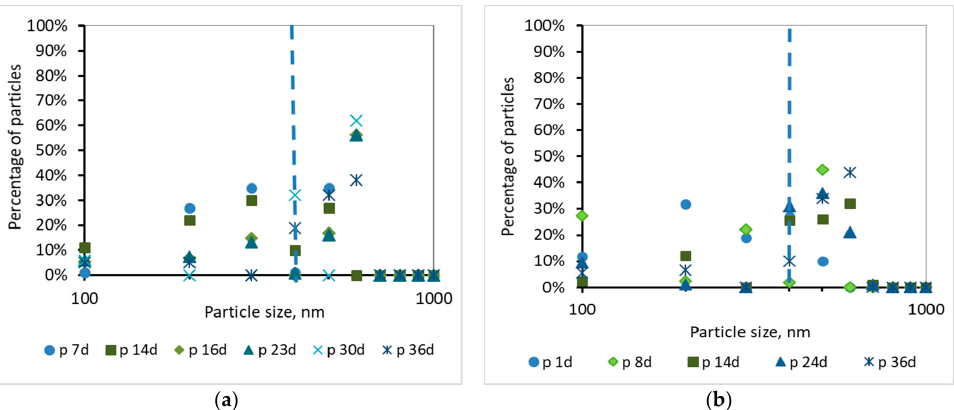
Figure 9. Cumulative percentage of particles smaller than 1000 nm for a sample from the aeration tank (AT) as a function of MBR operation time ( a ) for synthetic versus ( b ) domestic wastewater.